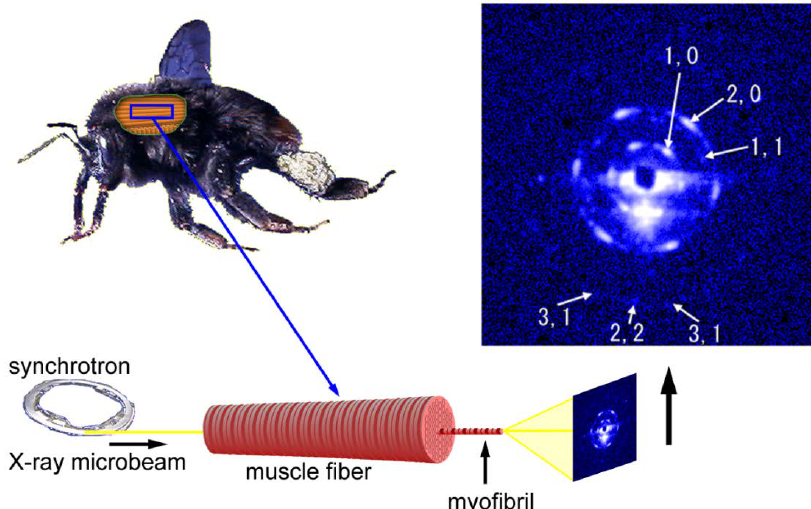
Figure 6. Geometry of diffraction recording (end-on configuration) from a single myofibril within a flight muscle fiber of a bumblebee by using an X-ray microbeam. The beam diameter was 2 µm and one of the first diffraction patterns recorded from a single myofibril is shown on the right. The pattern shown here is identical to the one shown in Reference